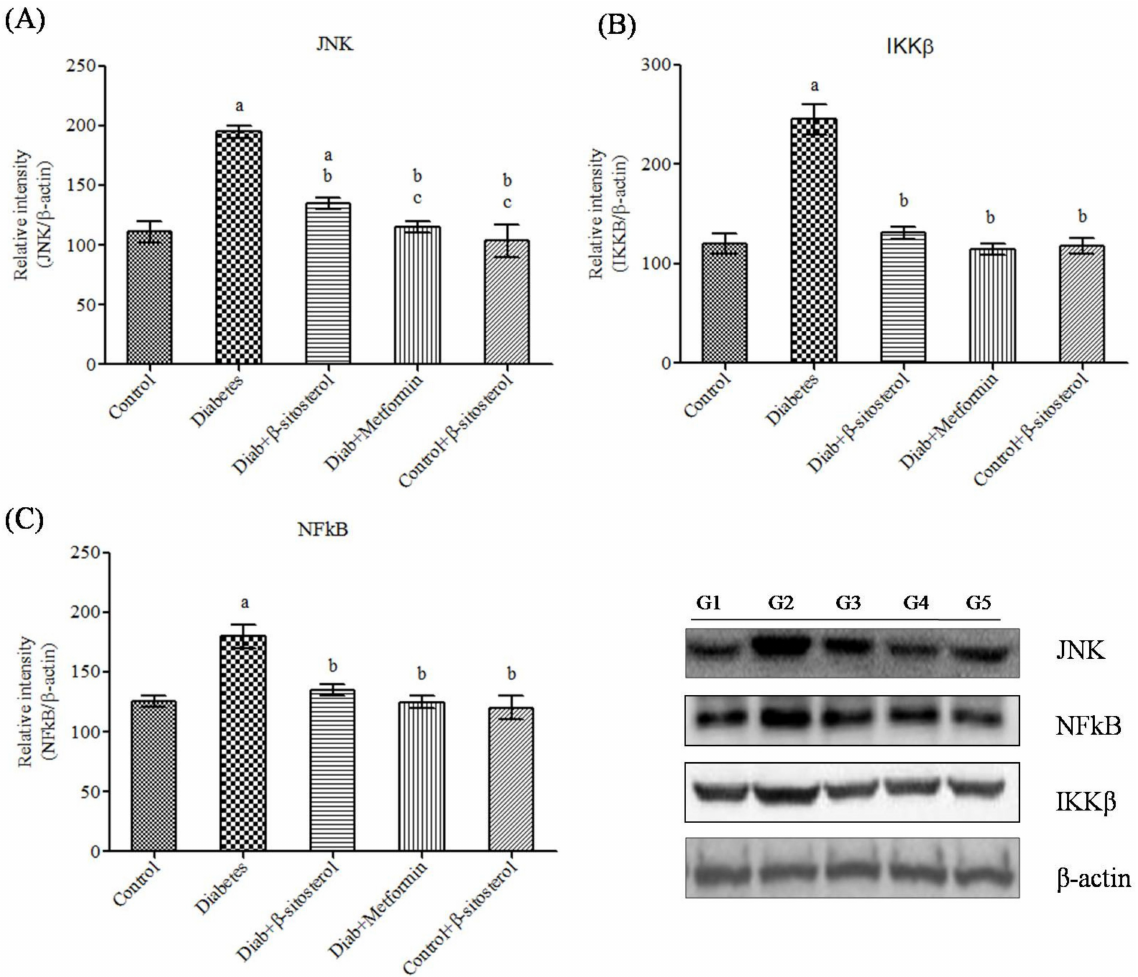
Figure 12. ( A–C ) Effect of SIT on JNK, IKK β and NFkB protein expression in adipose tissue of type-2 diabetic rats. The expressions of JNK, IKK β and NFkB proteins were assessed by Western blotting. B-actin was used as a loading control. Each bar represents mean ± SEM ( n = 6). G1—Normal control rats, G2—diabetic rats, G3—diabetic rats treated with SIT, G4—diabetic rats treated with metformin and G5—control rats treated with β -sitosterol. Significance at p < 0.05, a significantly different from the control group and b significantly different from the diabetic